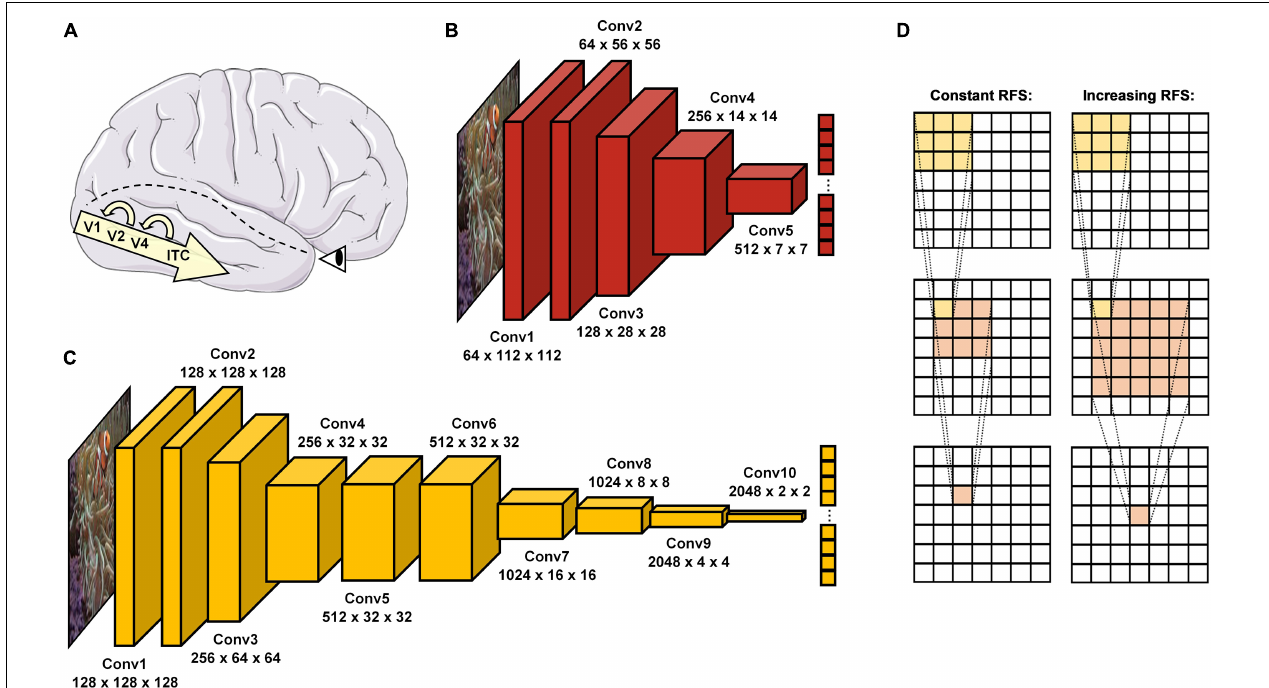
FIGURE 1 | Object recognition in the human brain and DCNNs. (A) In the brain, visual information enters via the retina before it passes through the ventral visual pathway, consisting of the visual cortex areas (V1, V2, and V4) and inferior temporal cortex (ITC). After a first feedforward sweep of information ( ∼ 150 ms), recurrent processes reconnecting higher to lower areas of this hierarchical cascade become activated and allow more in-depth visual processing. (B) ResNet18 (He et al., 2016) is a standard DCNN with 5 convolutional layers. (C) vNet (Mehrer et al., 2021) is a novel DCNN with 10 convolutional layers and modified effective kernel sizes, which simulate the progressively increasing receptive field size (RFS) in the ventral visual pathway. (D) Schematic overview of convolutions with a constant and increasing RFS. An increasing RFS raises the number of pixels represented within individual neurons of the later layers. Below individual layer names, the first number represents the feature map size while the second and third indicate the obtained output